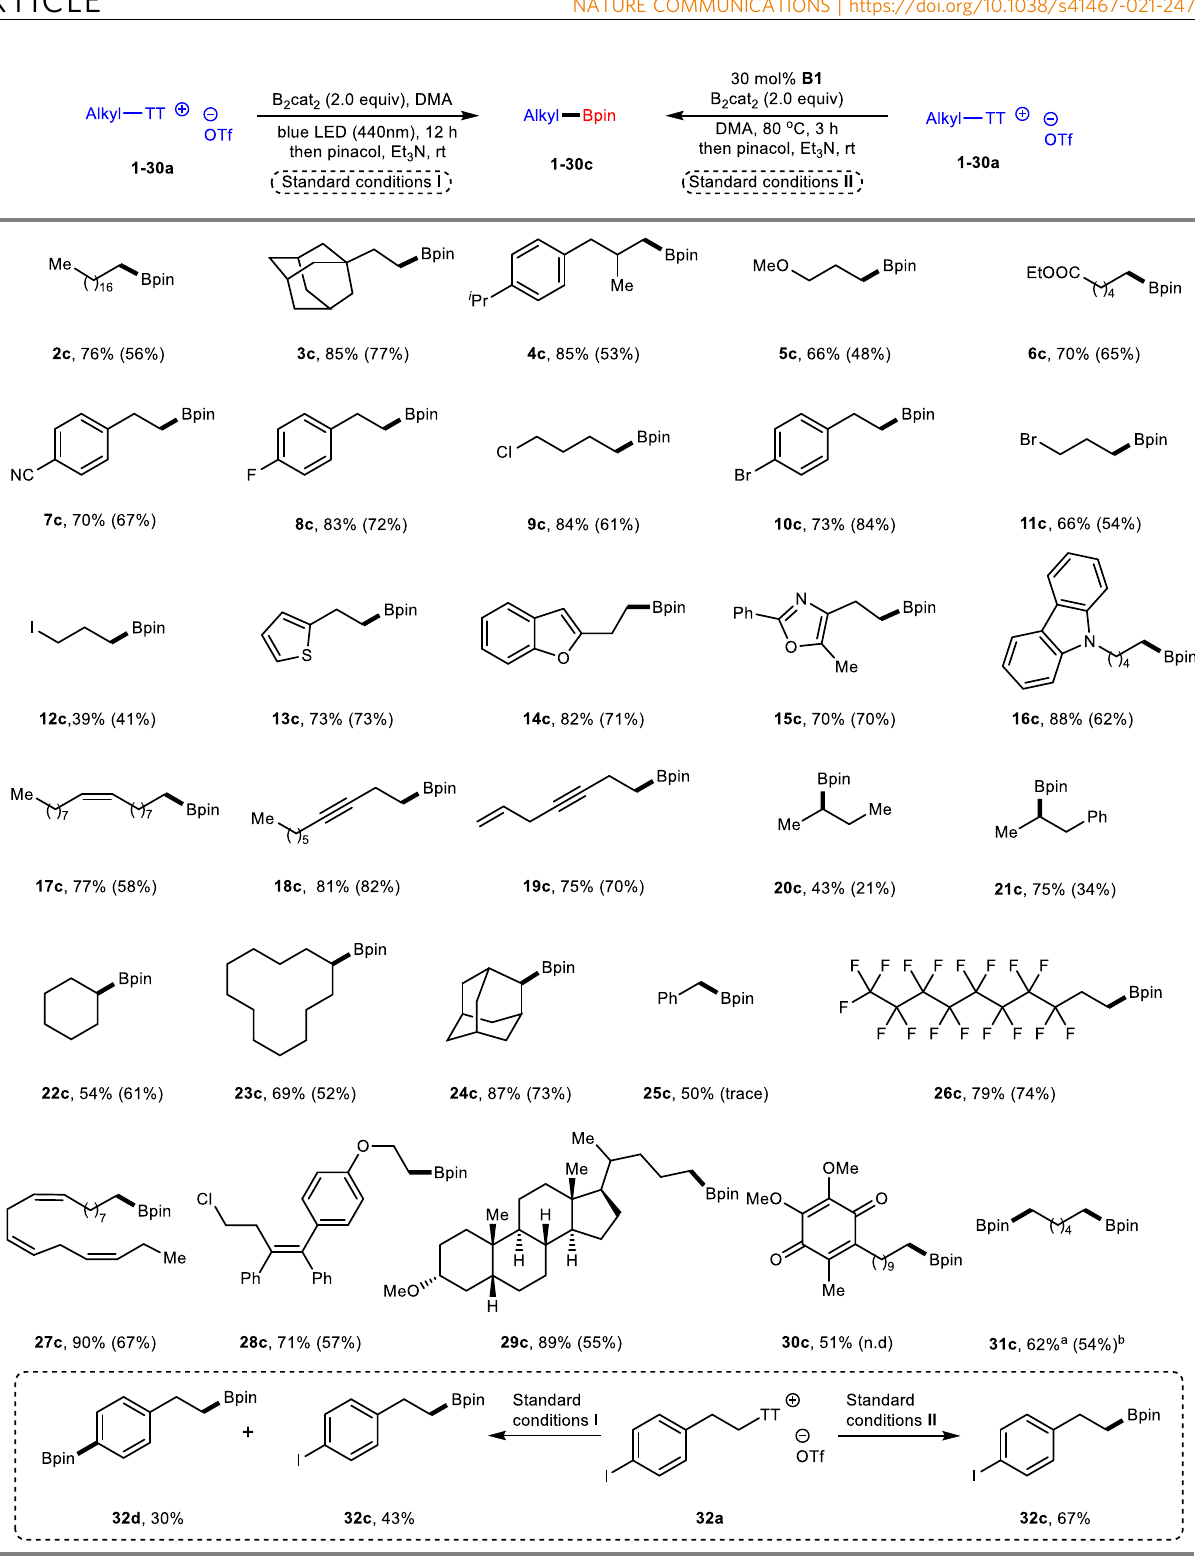
Fig. 4 Substrate scope of S -(alkyl) thianthrenium salts under photo- and thermo-induced conditions. Standard conditions I : thianthrenium salts 1 – 32a (0.40 mmol), B 2 cat 2 (0.80 mmol) in 1.0 mL DMA, irradiation from a 40 W Kessil blue LED bulb (440 nm) for 12 h under Ar; then pinacol (1.60 mmol) in 1.0 mL Et 3 N was added to the mixture, 1 h, isolated yields; Standard conditions II: thianthrenium salts 1 – 32a (0.40 mmol), B 2 cat 2 (0.80 mmol), 30 mol% of B1 in DMA (1.0 mL), 80 °C, 3 h, under Ar, isolated yields; The yields in standard conditions II were afforded in parentheses. a B 2 cat 2 (1.60 mmol) in